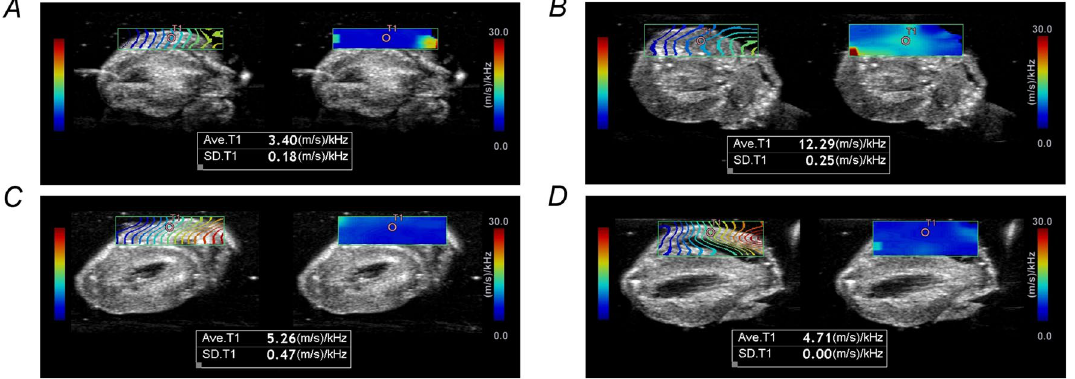
Figure 3. SWDS images. SW propagation image (left side) and SWDS image (right side) of RVFW in the control group ( A ), the EAM 3-week group ( B ), the EAM 5-week group ( C ), and the EAM 7-week group ( D ). The value of SWDS in a circular ROI of 1-mm in diameter on the myocardium was measured. EAM experimental autoimmune myocarditis, ROI region of interest, RVFW right ventricular free wall, SW shear wave, SWDS shear wave dispersion